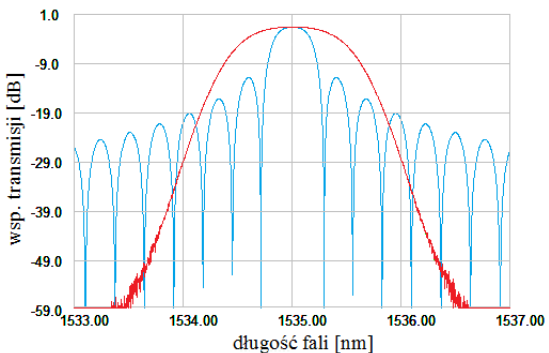
Fig. 21. Comparison of Bragg fiber gratings spectral characteristics without apodization – blue line and apodized sine function for wsp. X=5 and Y=1 – red line.